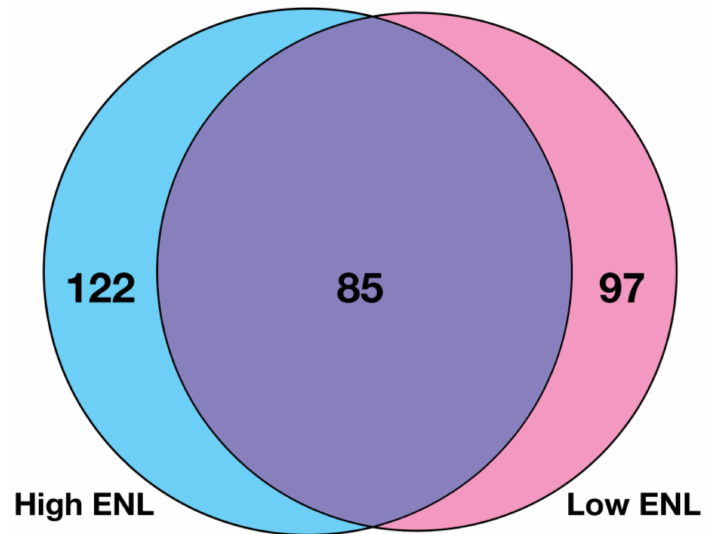
Figure 4. Venn diagram representing individual genes used to generate the top 500 LDA three-gene classifiers for each ENL phenotype.